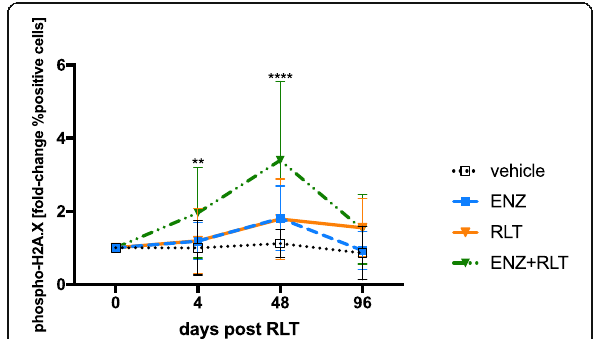
Fig. 4 Pre-treatment with ENZ increases 177 Lu-PSMA617-induced DNA damage. Phospho- γ H2A.X levels were flow cytometrically quantified in FNA tumor biopsies 4 h, 48 h, and 96 h following administration of 177 Lu-PSMA617 or vehicle, respectively. The fold-change in phospho- γ H2A.X compared to baseline (day before RLT) is shown as mean±SD. Asterisks indicate significance in ENZ+RLT-treated tumors compared to baseline (ENZ+RLT: 0 vs. 4 h, p =0.003; 0 vs. 48 h, p